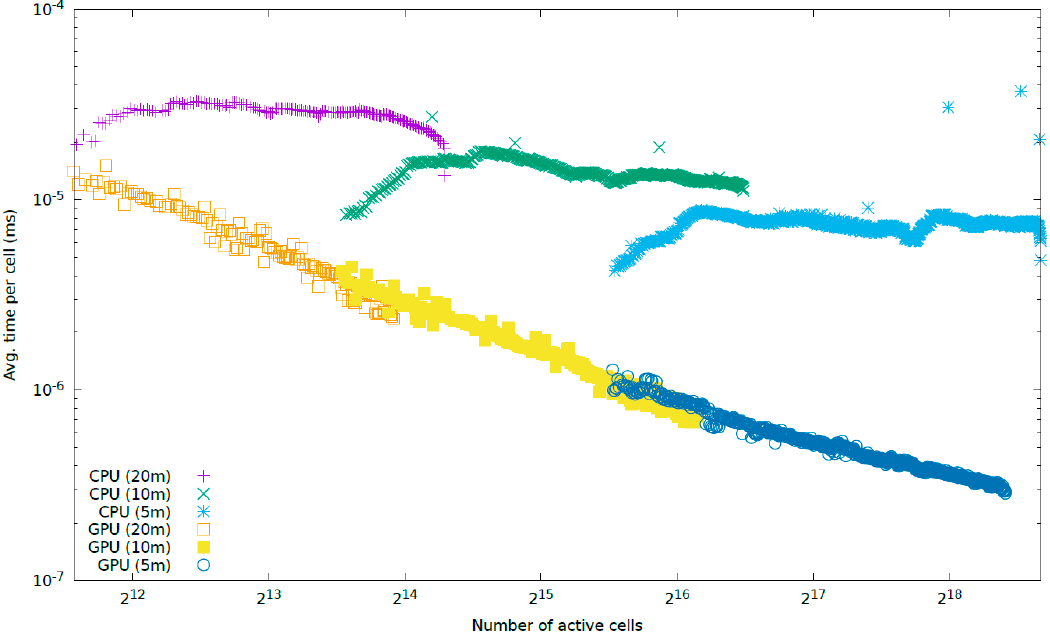
Figure 6. Average time (in ms) needed for a full iteration for a single cell. Simulations were run using the CPU and GPU versions of GPUFLOW at different resolutions (5, 10, and 20 m).